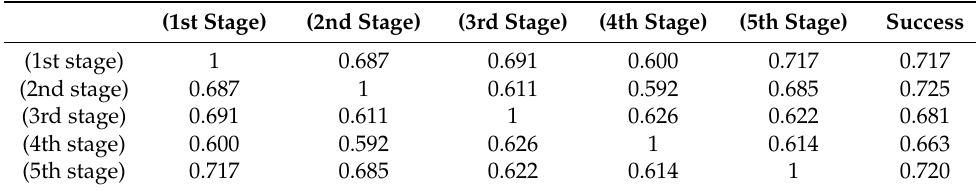
Table 4. Correlation analysis.